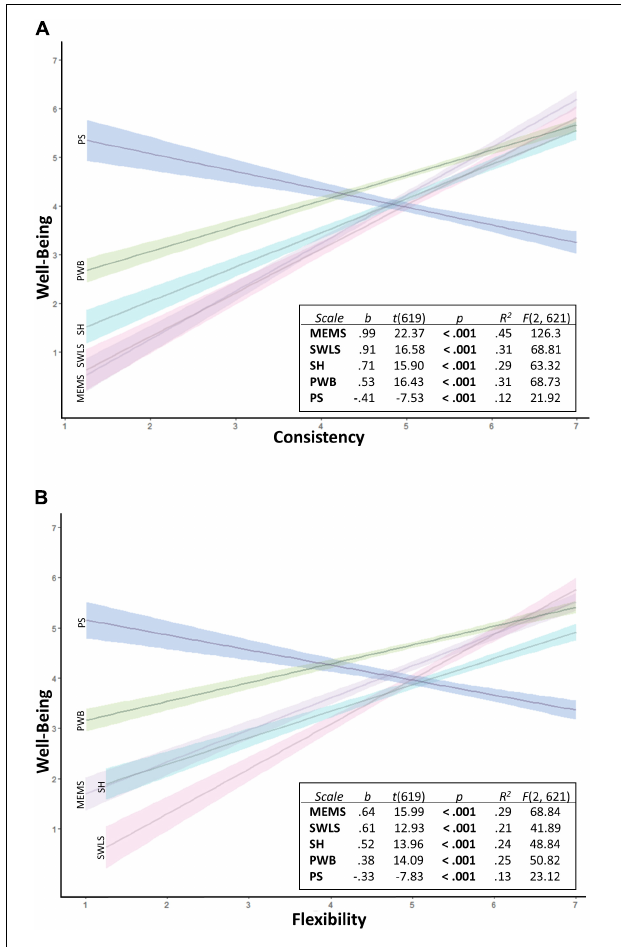
FIGURE 7 | Study 3: (A) Replicated regression analyses confirming convergence and divergence validity of the Consistency subscale. (B) Replicated regression analysis confirming convergence and divergence validity of the Flexibility. MEMS, Multidimensional Existential Meaning Scale; SWLS, Satisfaction with Life Scale; SH, Subjective Happiness; PWB, Psychological Well-Being; PS, Perceived